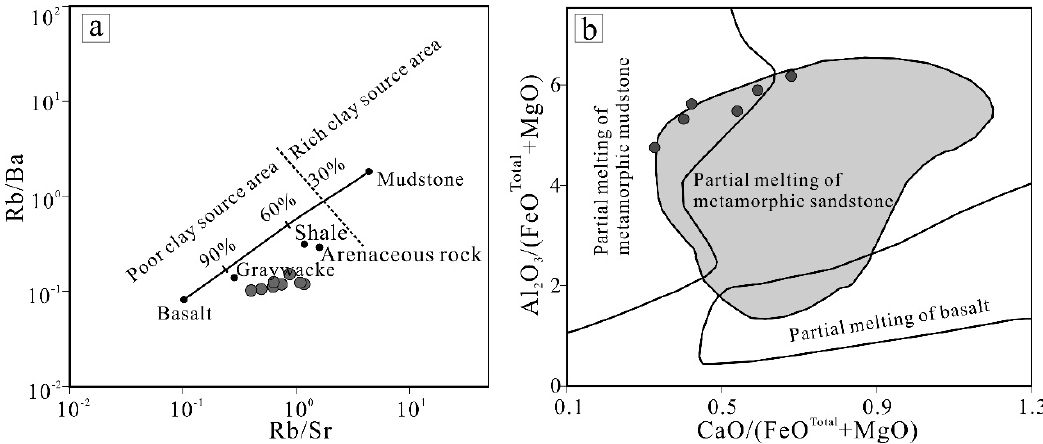
Figure 12. Rb/Sr versus Rb/Ba ( a ) and CaO/(FeO Total + MgO) versus Al 2 O 3 /(FeO Total + MgO) ( b ) diagrams for the Xiajinbao granite.